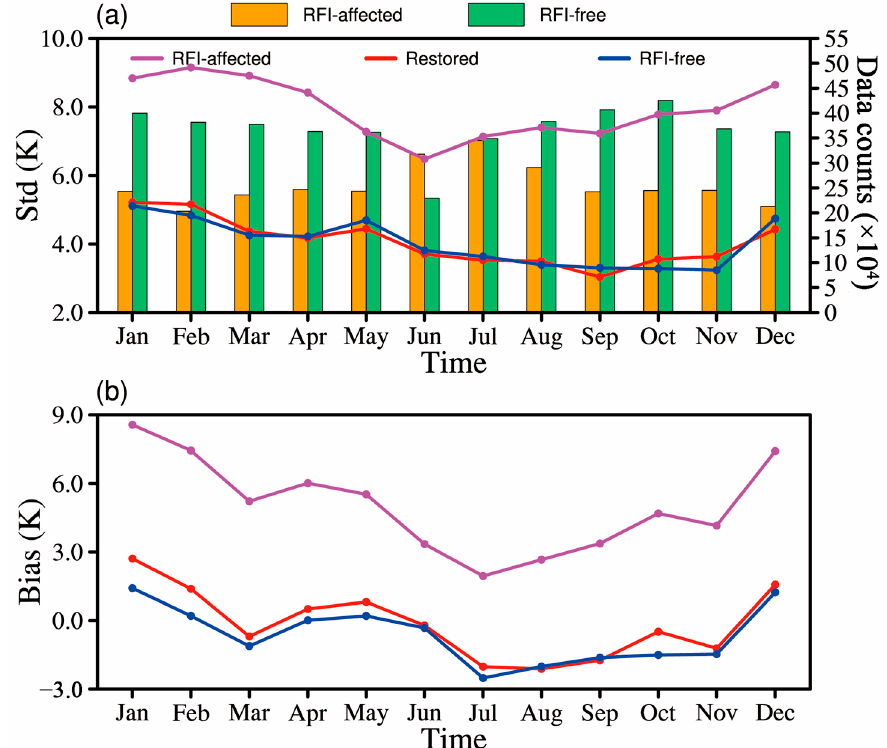
Figure 8. Monthly variations of the OMB standard deviation ( a ) and bias ( b ) obtained from the RFI-affected data before (magenta) and after (red) the restoration process and from the RFI-free data (blue) in 2016. The column bars represent the counts of considered data.